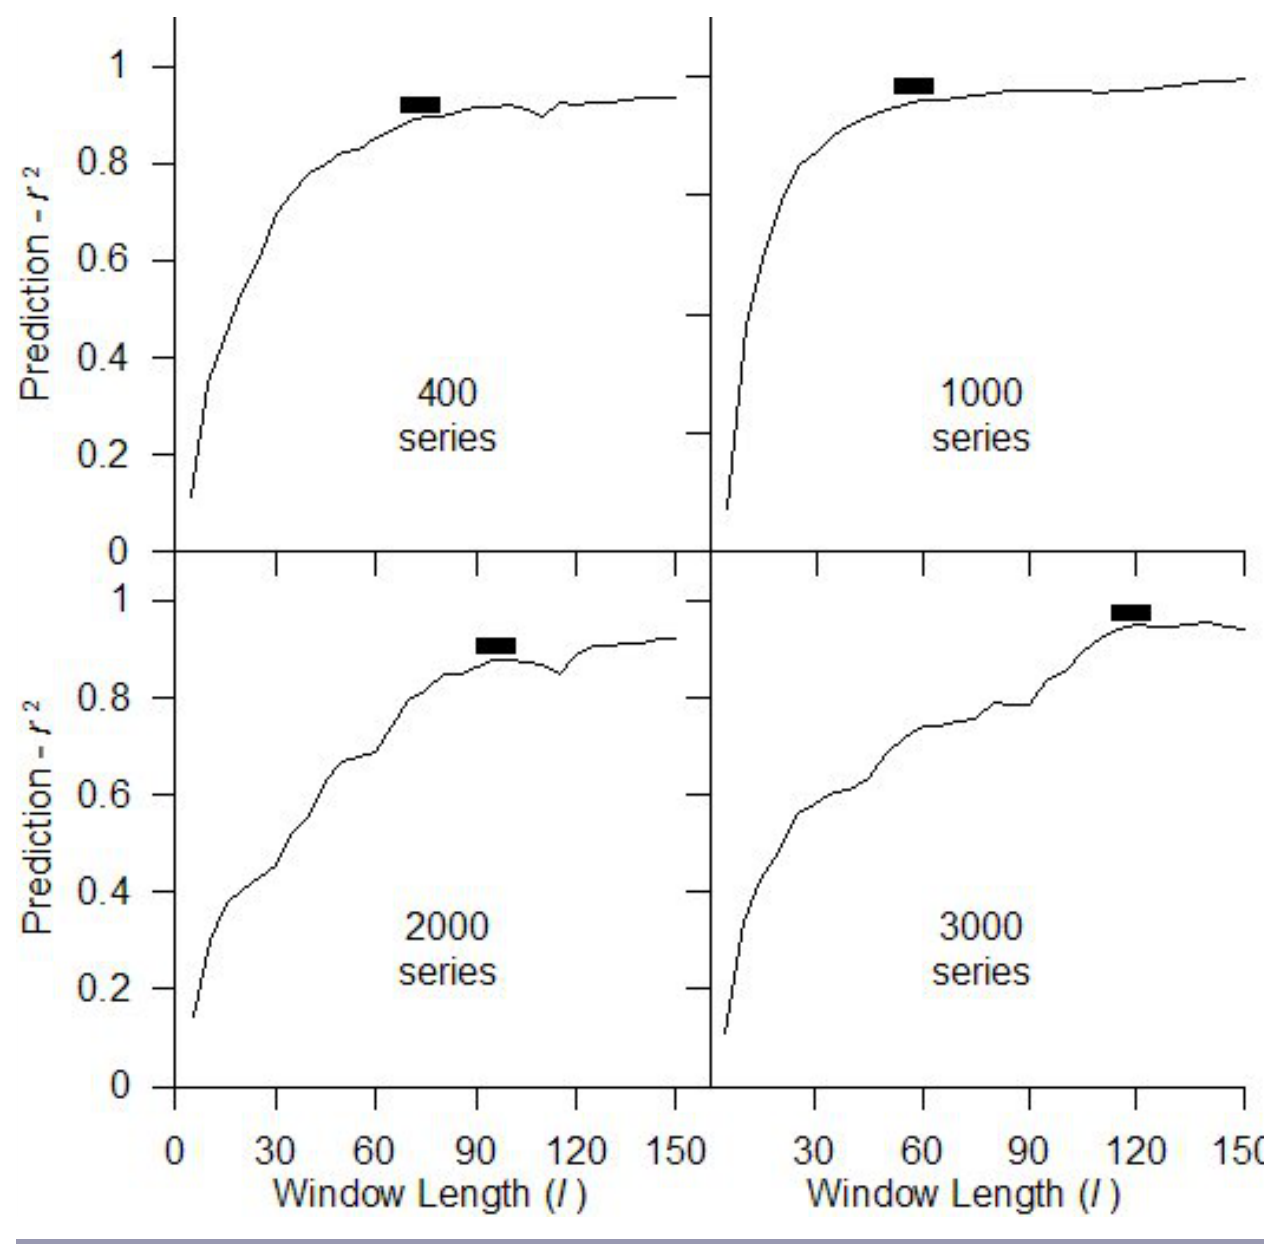
Fig. 4. The effect of changing community dynamics on the CLS of the five-species system shown in Fig. 2B. Prediction-r 2 spectra (based on analysis of densities of S ) produced from series of five maps of the 1 landscape commencing at generation 400 (before a change in the nature of the interaction between S 1 and S at generation = 500) and, after the shift in the outcome of the interaction, commencing at 2 generations 1000, 2000, and 3000. Consecutive maps in each series were separated by 10 time steps. The change in dynamics is reflected by an increase in the CLS from about 75 to about 120 length units. Areas identifying the CLS are shown as black horizontal